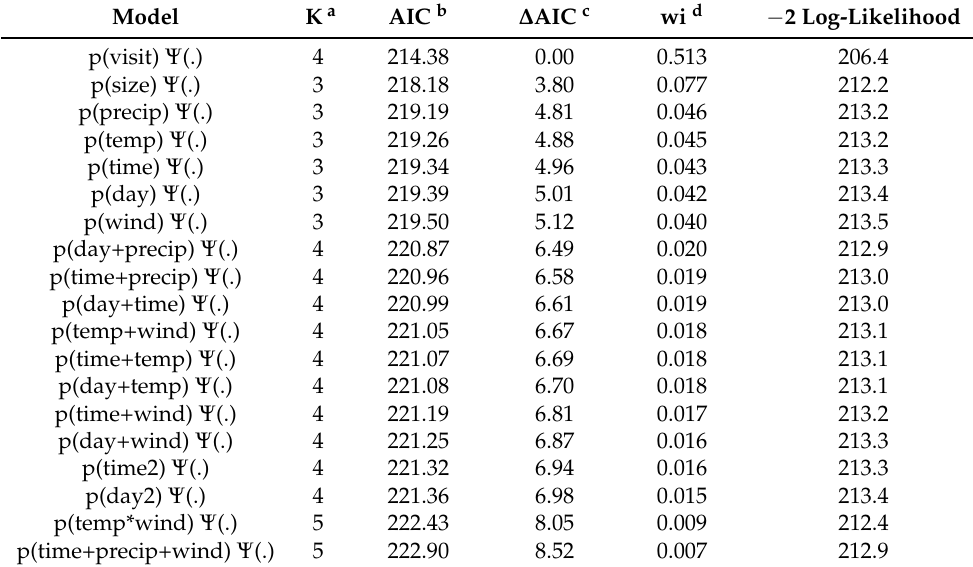
Table 2. Model selection for detectability of Rusty Blackbirds in northern New England in 2014. Model K a AIC b ∆ AIC